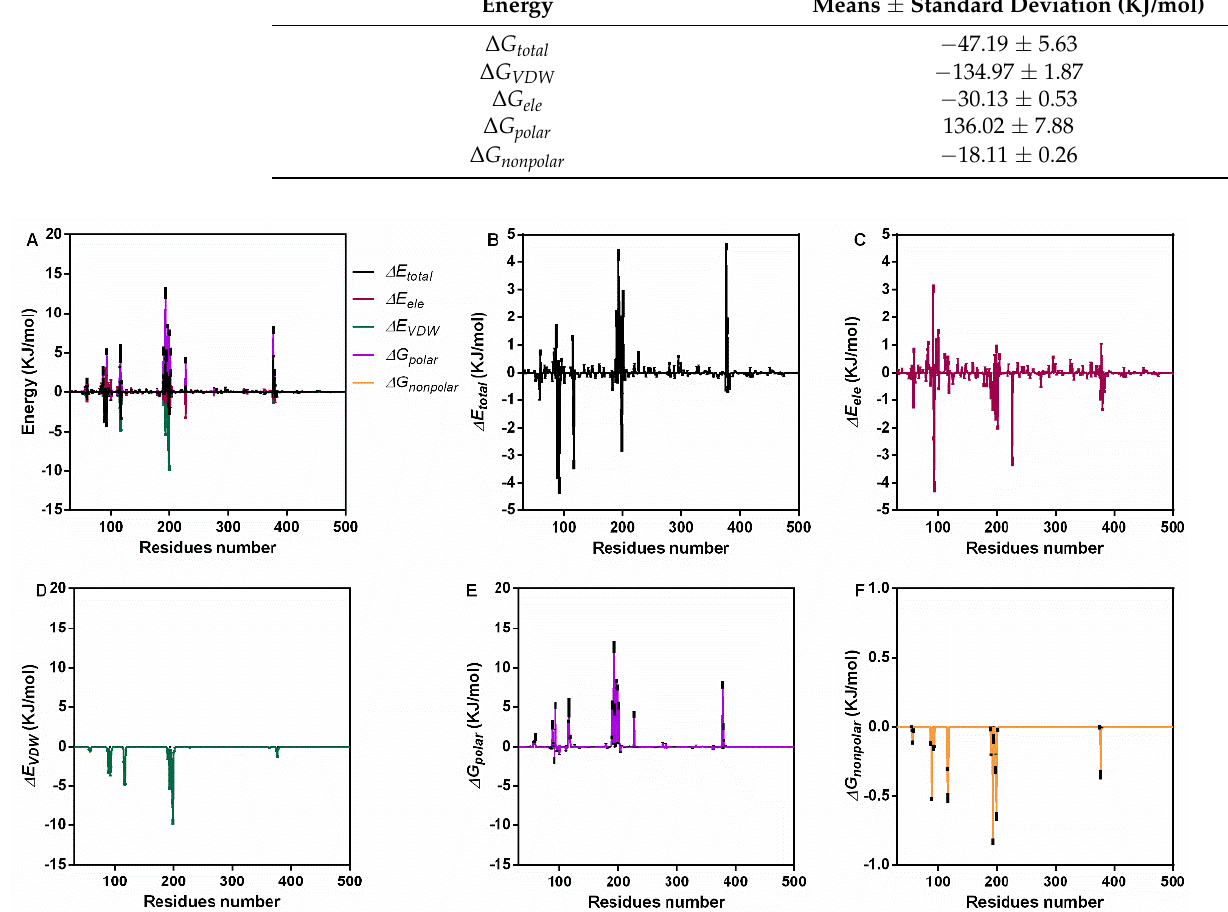
Figure 3. The interaction energy of piceatannol and PFO during the binding process. ( A ) The contribution of all kinds of energy. ( B ) The total energy values during binding. ( C ) The electrostatic energy. ( D ) The VDW interaction energy. ( E , F ) The polar and nonpolar action energies. Then, the exact residues were extracted (Figure 4A), 58Asp, 89Pro, 92Ile, 93Ser, 101Arg, 116Glu, 117Asn, 183Glu, 192Ile, 198Val, 199Asn and 200Ala showed higher total binding energy among all residues (Figure 4B); 58Asp, 92Ile, 93Ser, and 198Val mainly generated electrostatic interactions with piceatannol (Figure 4C); 89Pro, 116Glu, 117Asn, and 199Asn contributed both VDW force and nonpolar interactions (Figure 4D,E), promising a relatively higher total binding energy; and 92Ile, 93Ser, 116Glu, 198Val, and 199Asn generated polar interactions (Figure